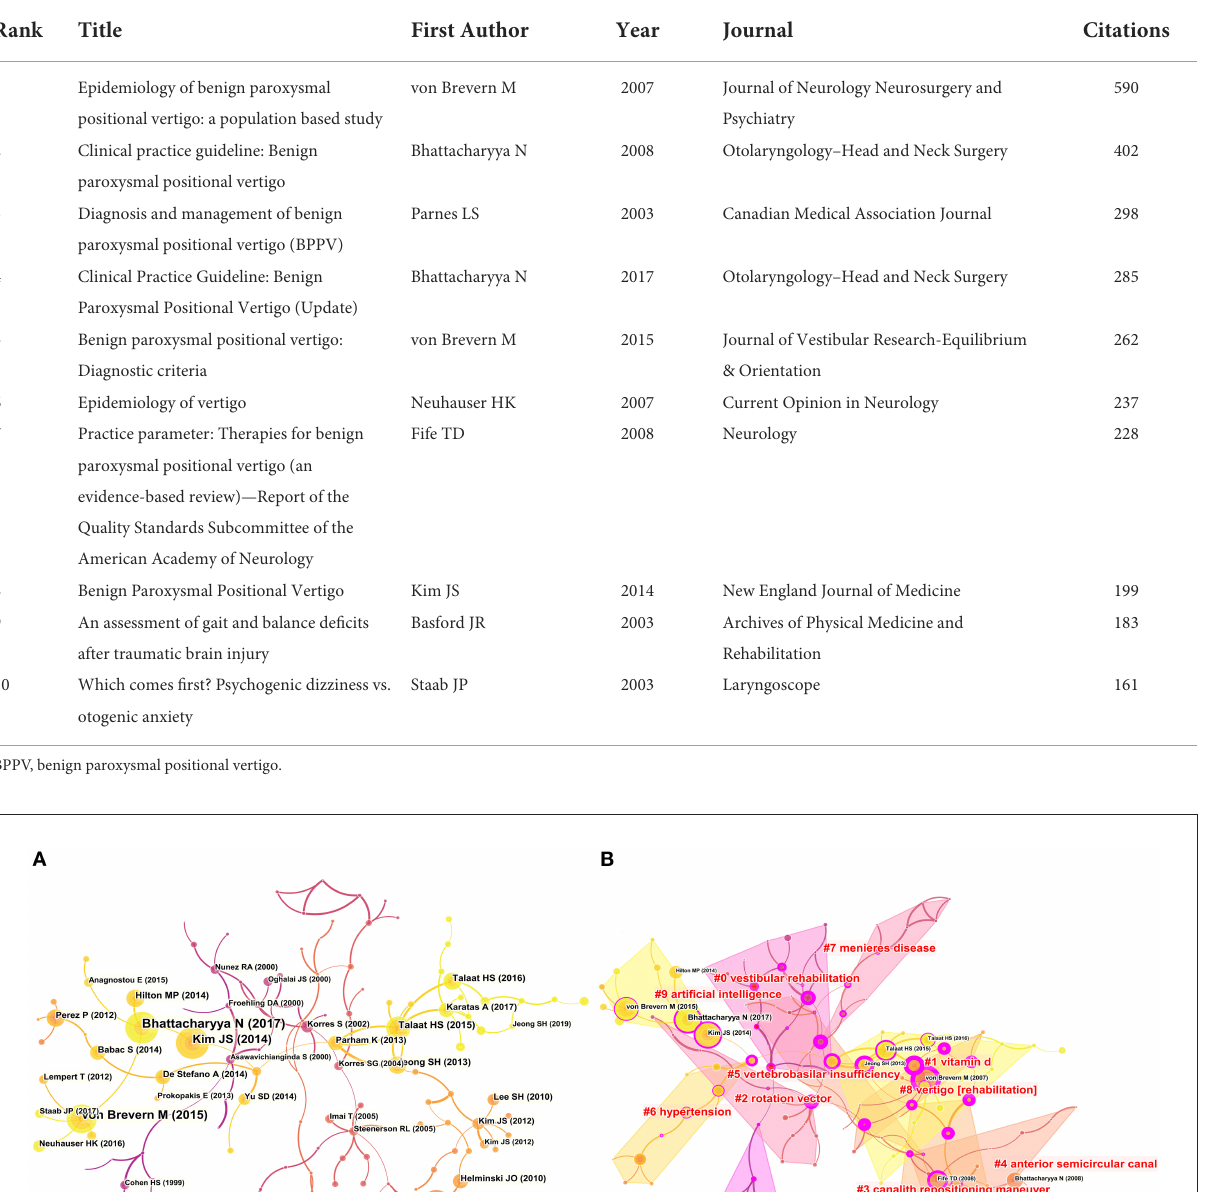
TABLE 4 The top-10 co-cited publications related to BPPV.